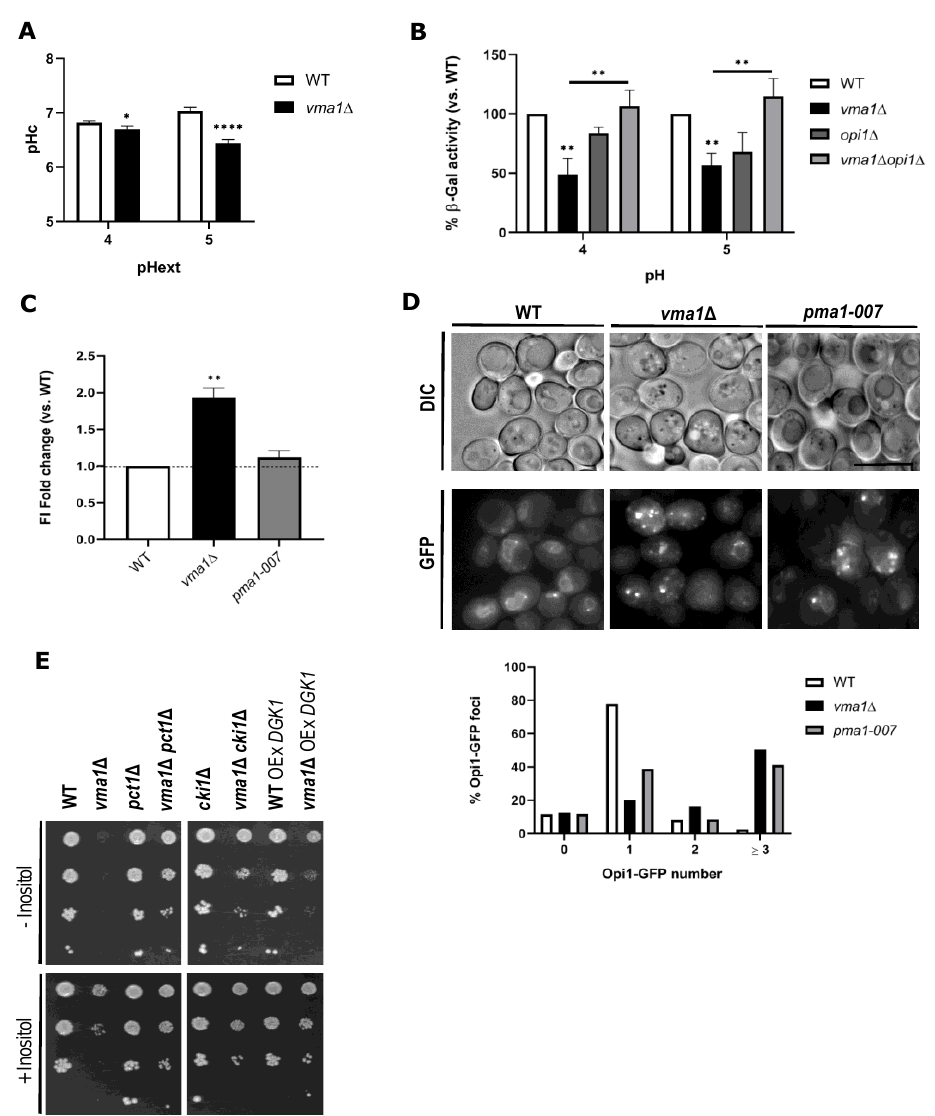
Figure 5. Cytosolic acidification leads to alterations in Opi1 transcriptional repressor activity and localization, thus contributing to aberrant lipid metabolism and inositol auxotrophy. ( A ) Cells devoid of VMA1 display cytosolic acidification. pHc was measured with a pH-sensitive GFP probe (pHluorin) as described in Section 3. Cells were grown to an exponential phase in SC media buffered at the indicated pH. ( B ) Opi1-mediated repression of INO1 promoter activity in vma1 ∆ cells. Overnight precultures grown in SC medium lacking inositol and leucine were diluted and allowed to grow to reach an exponential phase in fresh media buffered at the indicated pH. Protein extracts were prepared, and specific β -Gal activities were determined as in Figure 2C. Results are shown as a percentage of WT levels. ( C ) Higher Opi1 repressor activity is associated with higher Opi1-GFP levels in vma1 ∆ cells. WT, vma1 ∆ , and pma-1007 cells expressing Opi1-GFP were grown in SC medium lacking leucine, as described in Figure 1B, and fluorescence intensity analysis of the GFP signal was performed by flow cytometry (FL1 channel). For each strain, shown are FI fold changes vs. WT. ( D ) Altered intracellular pH affects Opi1 localization in vma1 ∆ and pma-1007 strains. WT, vma1 ∆ , and pma-1007 cells expressing Opi1-GFP were grown in SC medium to exponential phase. Opi1-GFP localization was monitored by fluorescence microscopy (higher panel) and quantification of the number of Opi1-GFP puncta is defined as a percentage of Opi1-GFP foci ( n > 100 cells; lower panel). Scale bar, 2 µ m. DIC—Differential Interference Contrast; GFP—Green Fluorescent Protein. ( E ) Inactivation of the CDP-choline pathway or DGK1 expression suppresses the inositol auxotrophy in vma1 ∆ cells. Cells of indicated genotypes were grown in SC medium lacking inositol to the exponential phase and diluted to OD 600 = 0.1. Tenfold dilution series were spotted onto buffered SC plates (pH 5) without or supplemented with inositol and incubated at 26 ◦ C. Results are mean ± SD of at least three independent experiments. * p ≤ 0.05; ** p ≤ 0.01; **** p ≤